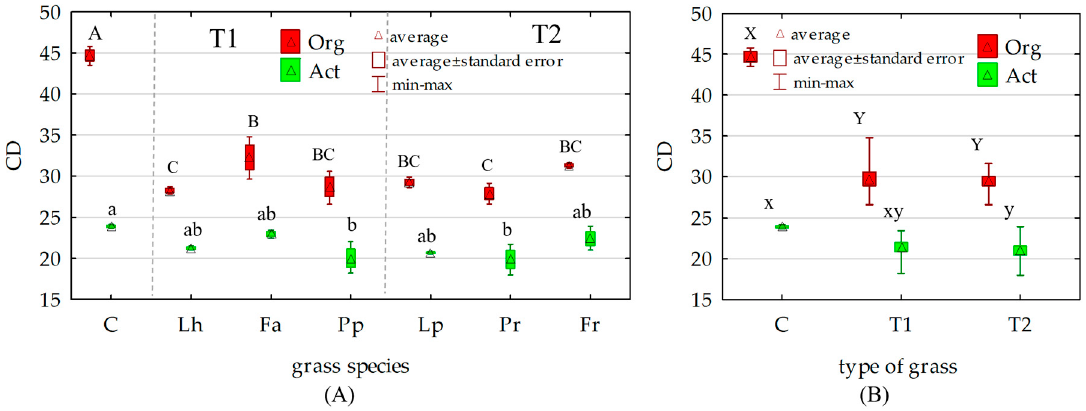
Figure 4. Colony development index (CD) of organotrophic bacteria (Org) and actinobacteria (Act): ( A ) depending on the species of grass, ( B ) depending on grass type (fodder or lawn). Homogeneous groups denoted were calculated separately for each microorganisms, groups denoted with letters (a–d) were calculated for the species of grass and groups denoted with letters (x–y) were calculated for the type of grass. C—unsown soil; Lh— Lolium x hybridum Hausskn; Fa— Festuca arundinacea ; Pp— Phleum pratense , Lp— Lolium perenne , Pr— Poa pratensis ; Fr— Festuca rubra.